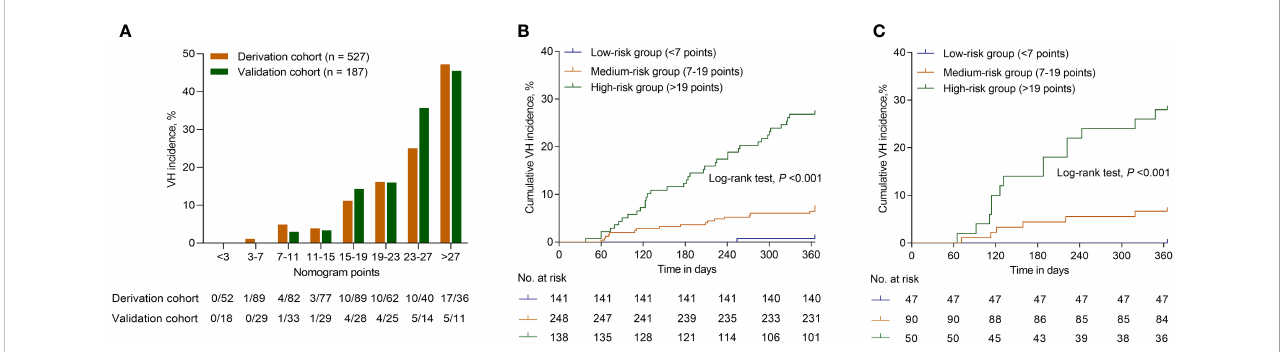
FIGURE 5 Risk for VH of patients with HBV-related GEVs with different scores. (A) The bars show the VH incidence for different score category in the derivation and validation cohorts. The cumulative VH incidence for patients categorized into different risk groups according to the nomogram in the derivation (B) and validation cohorts (C) . Abbreviations: VH, variceal hemorrhage; HBV, hepatitis B virus; GEV, gastroesophageal varice.